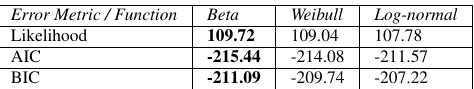
Table 3. PDF fitting error for both sensors as